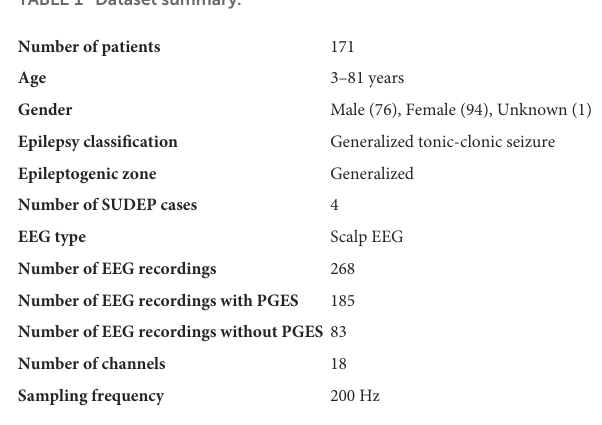
TABLE 1 Dataset